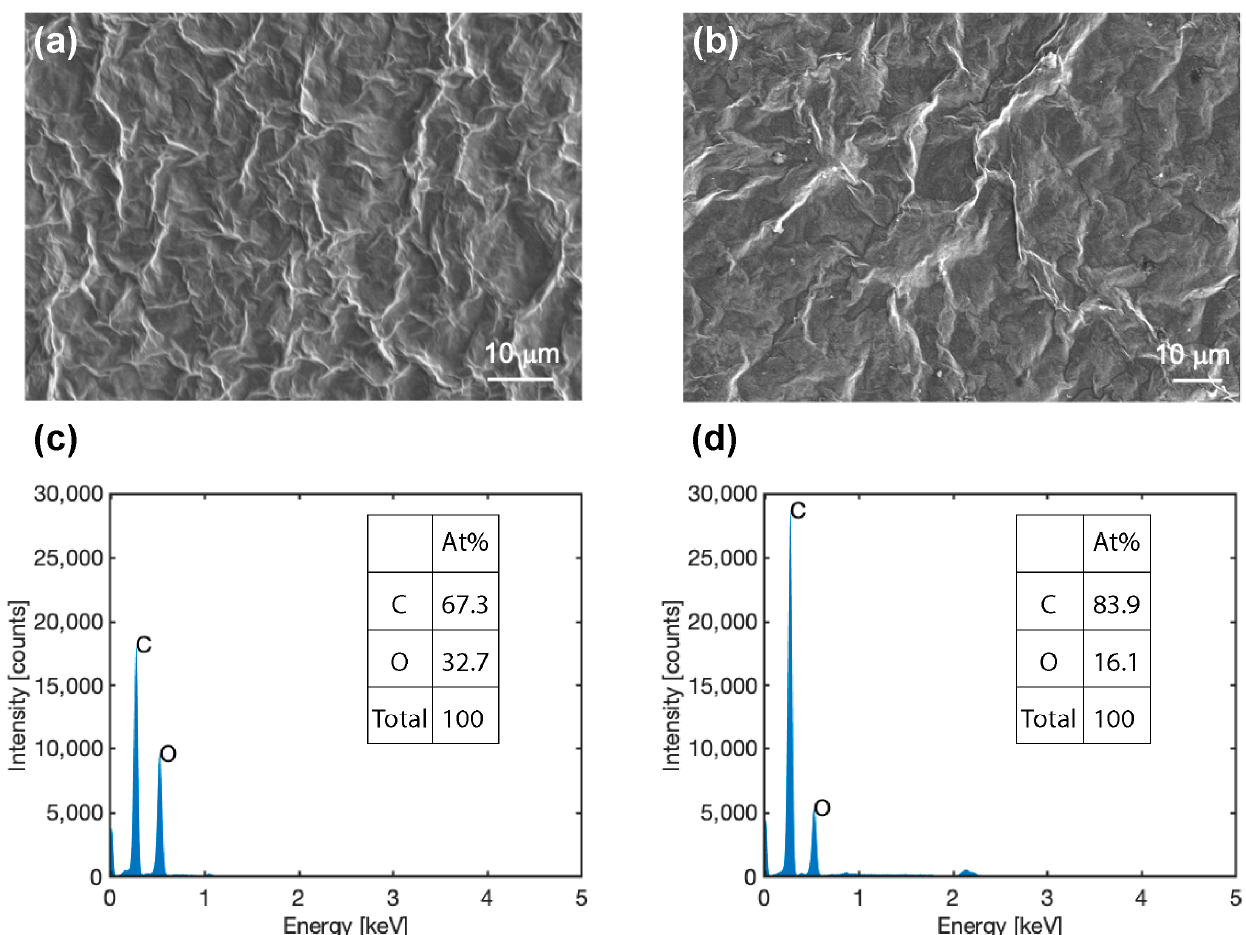
Figure 4. The SEM images describe the morphology of ( a ) a GO film and ( b ) an RGO film. The EDS spectra of ( c ) a GO film and ( d ) an RGO film are shown. Table 1. Exhaled breath biomarkers for different health